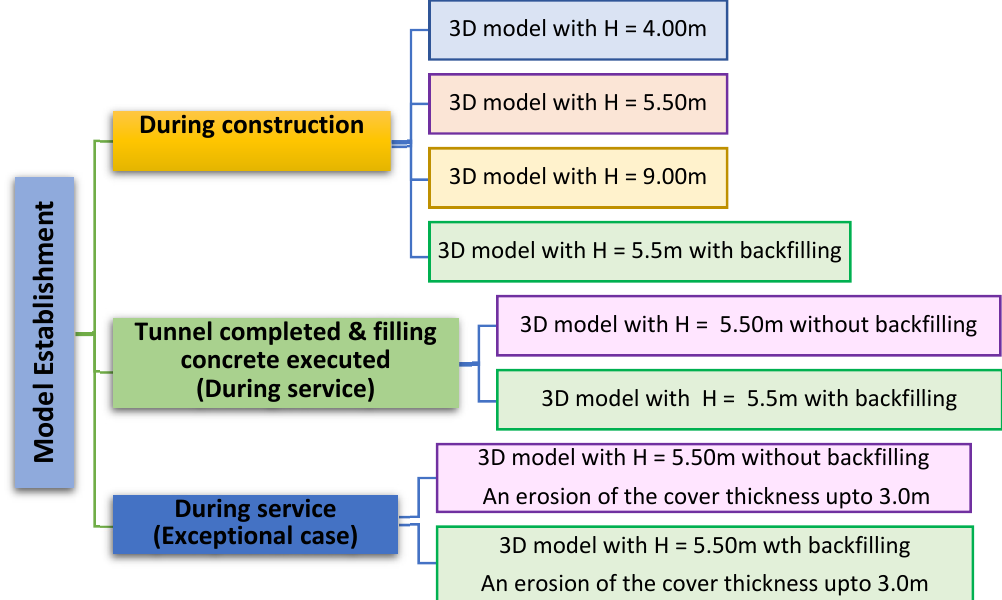
Figure 15. Numerical modeling development flowchart.